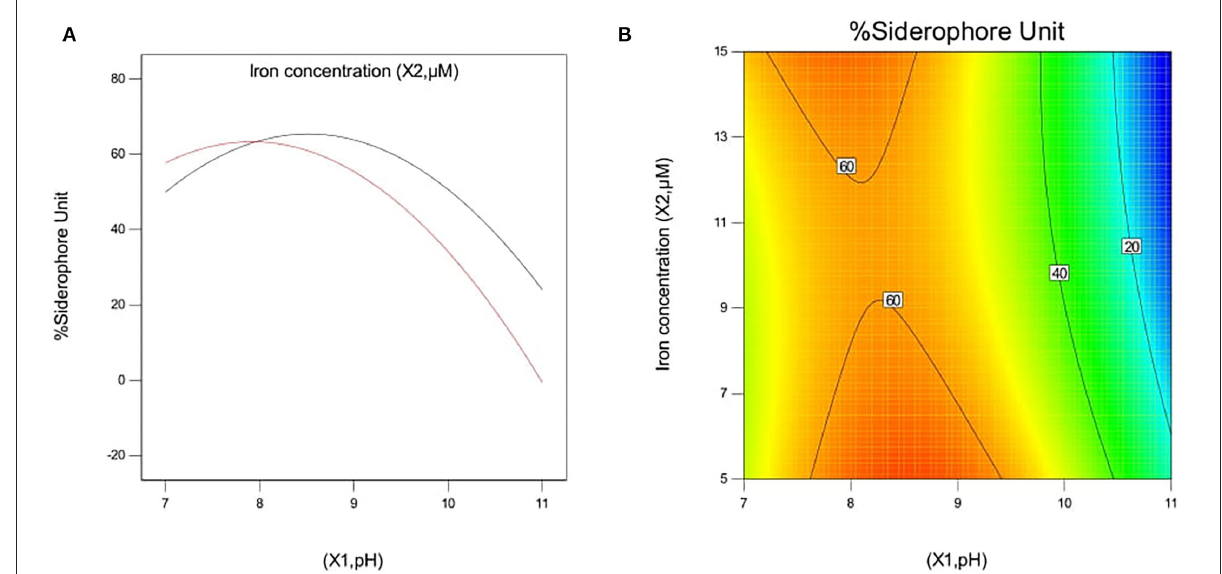
FIGURE4 Effect of pH and iron concentration on siderophore production In isolate B8 at optimized condition of ammonium nitrate concentration (X3, 15 g/l). (A) Interactive and (B) contour.